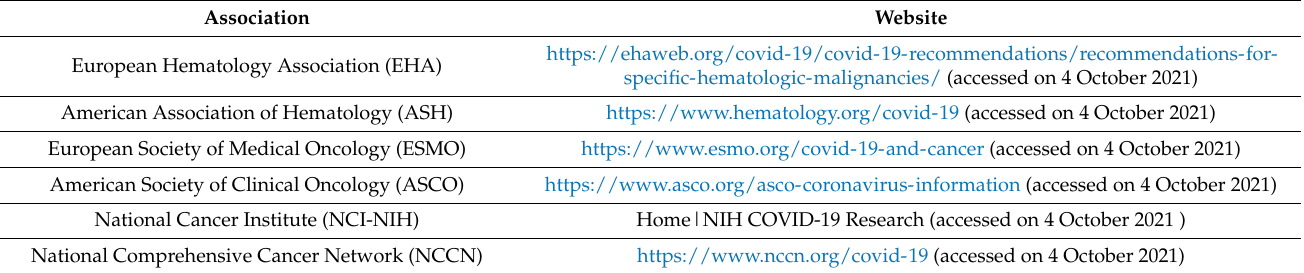
Table 2. Specific recommendations and continuously updated resources on COVID-19 in cancer